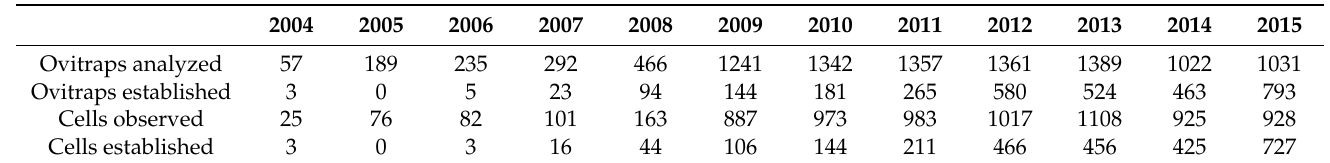
Table 1. Number of ovitraps analyzed in Ticino for the presence of Ae. albopictus , ovitraps with establishment of the mosquito, cells observed, and cells with